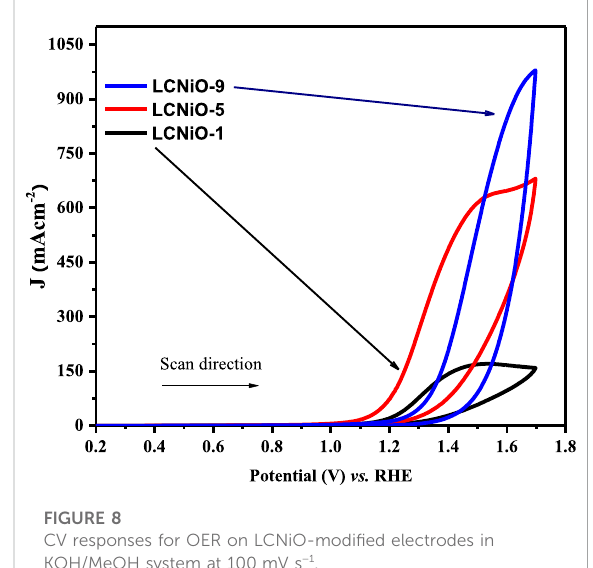
FIGURE 8 CV responses for OER on LCNiO-modi fi ed electrodes in KOH/MeOH system at 100 mV s − 1